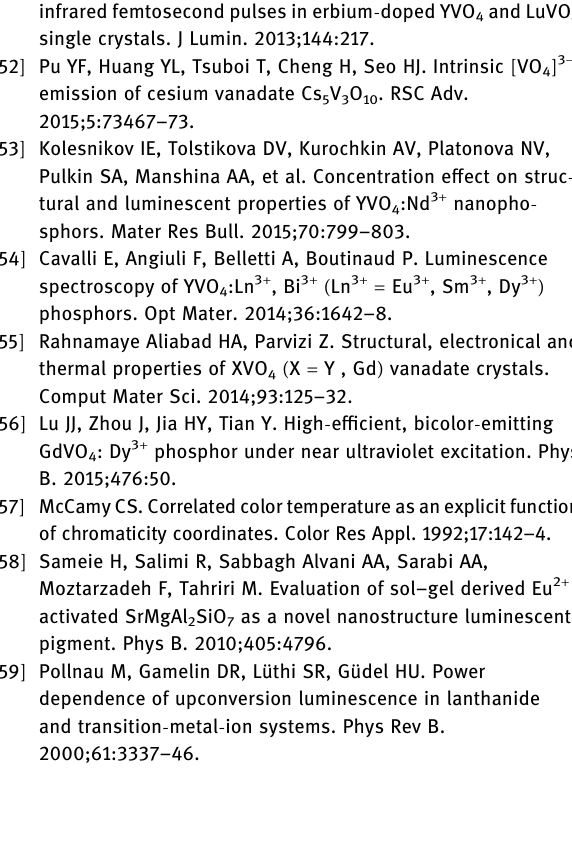
e ff ects on Czochralski grown Lu 2 Si 2 O 7 :Ce 3 + crystals under di ff erent atmospheres. J Appl Phys. 2008;103:083109.